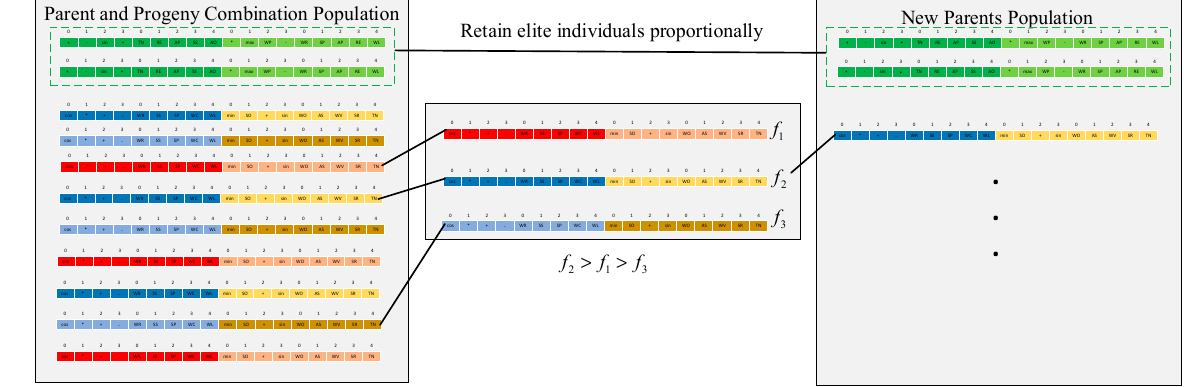
Figure 7. The selection of individuals in the population.